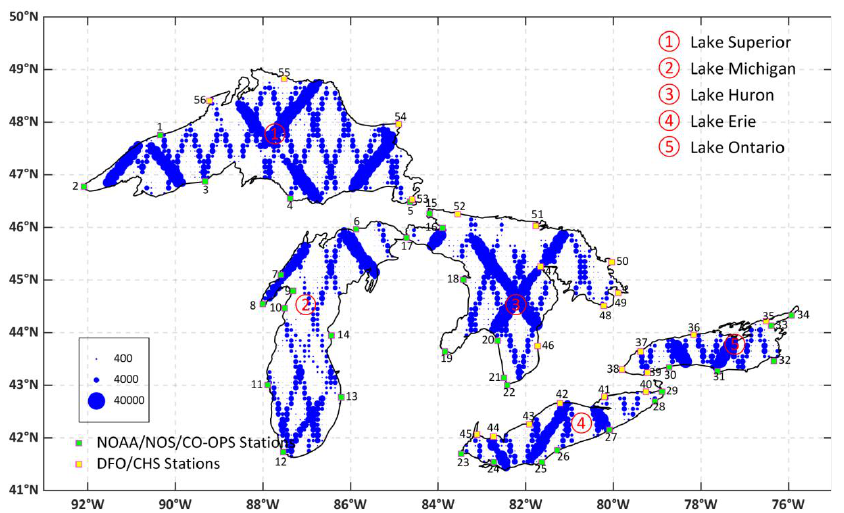
Figure 1. Available altimetry data within ~10 km is shown in blue circles on regular water level maps of the Great Lakes from April 1985 to September 2018. The locations of water level stations are depicted by squares: the green squares show water level stations from NOAA ’ s Center for Op- erational Oceanographic Products and Services (NOAA/NOS/CO-OPS), while the yellow squares are stations of the Department of Fisheries and Oceans ’ Canadian Hydrographic Service (DFO/CHS).